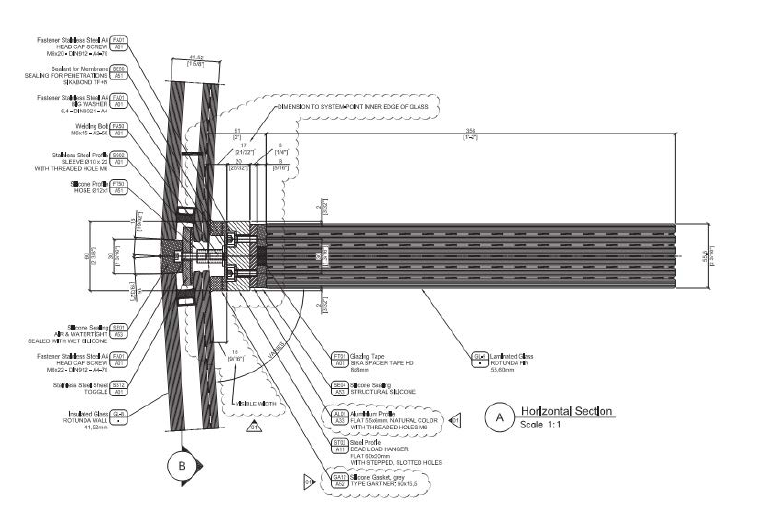
Fig. 4 Plan section of glass fin/wall.